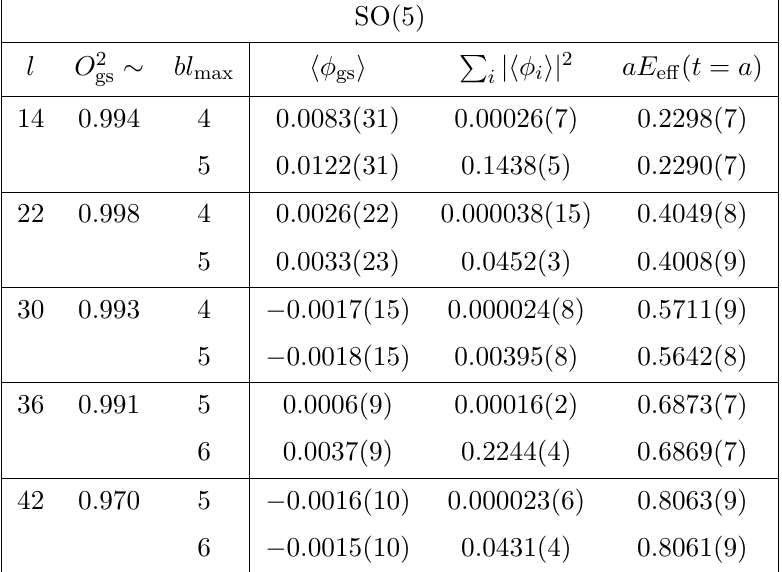
Table 8 . Various overlaps versus length, as described in section 4.2, in SO(5) at (cid:12) = 27 :